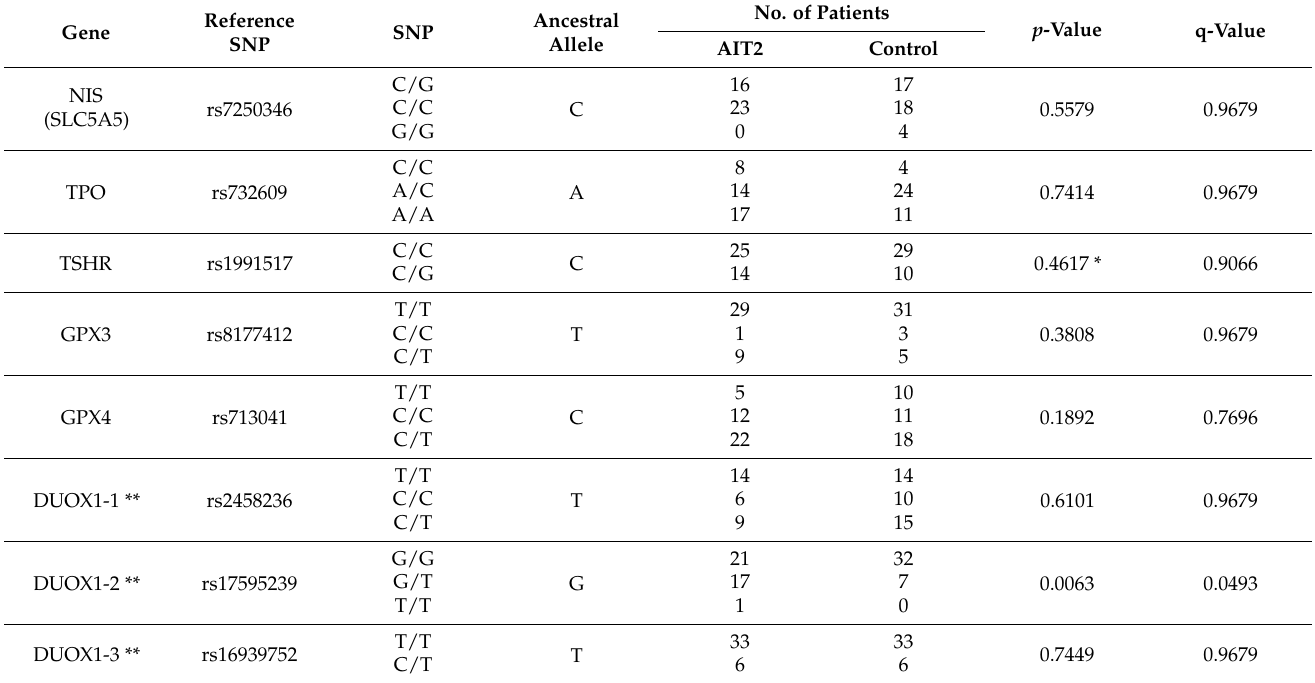
Table 2. Association between genotypes and clinical outcome. p -values are estimated by exact test of Cochran—Armitage trend test across genotypes.